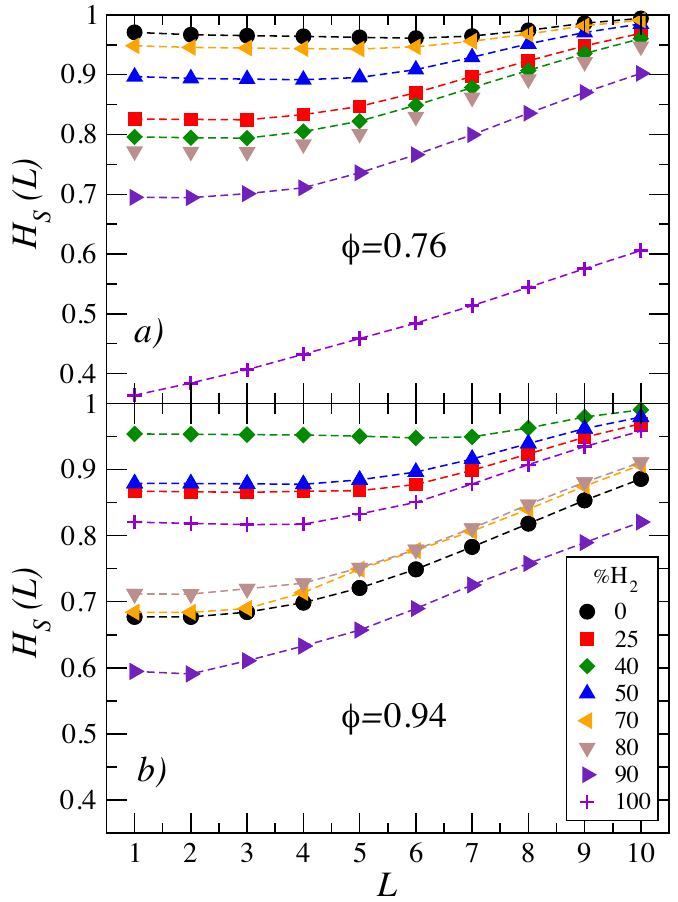
Figure 10. Evolution of the Shannon entropy, H s ( L ) , with the word length for two fuel–air ratios: ( a ) φ = 0.76 and ( b ) φ =